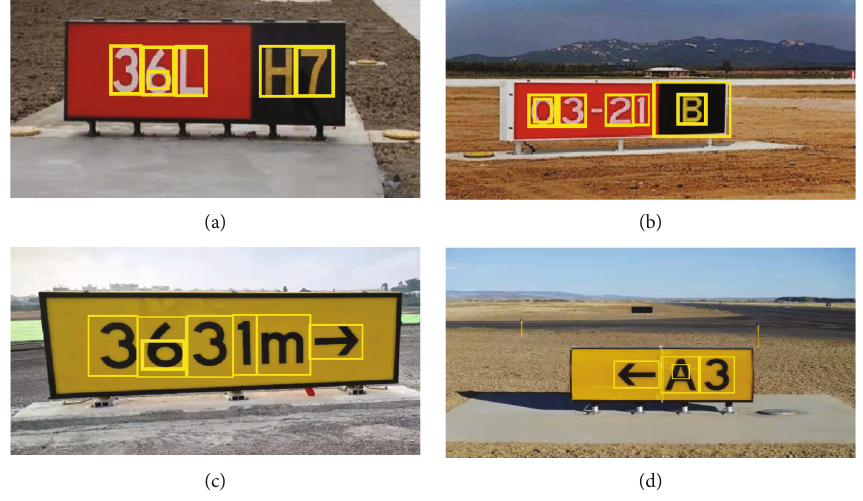
Figure 5: MSER-based split-character e ff ect images.